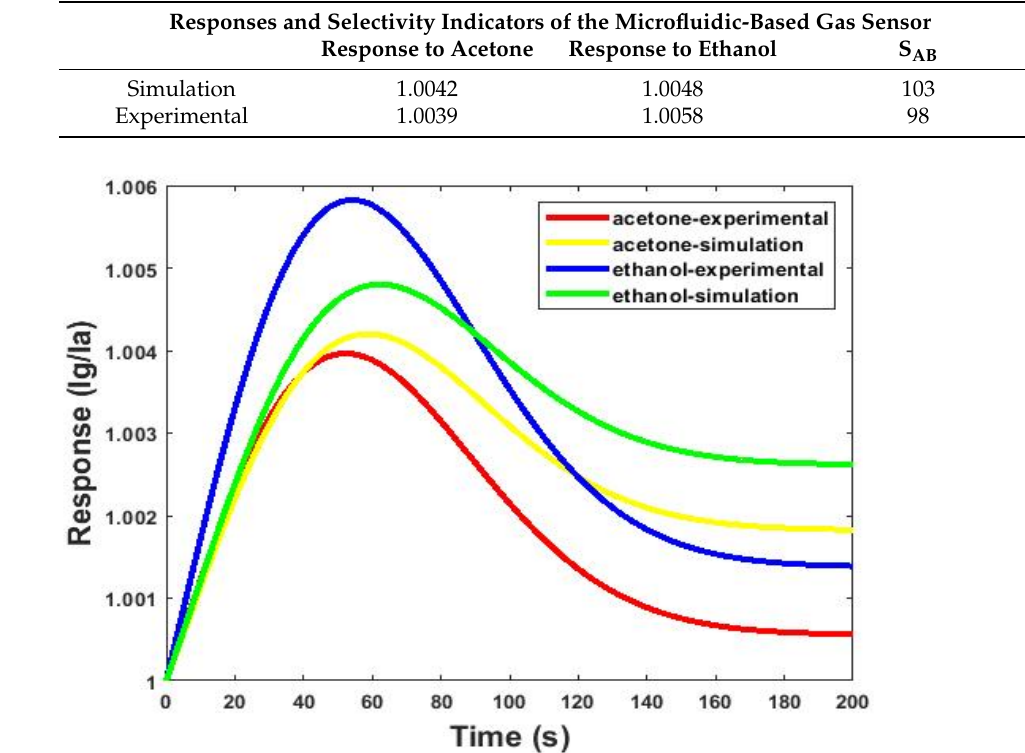
Figure 12. Comparison between the simulation and experimental results of the microfluidic-based gas sensor with optimal dimensions (W = 3 mm, L = 22.5 mm, H = 80 µm) in the presence of 2.6 ppm concentrations at 27 °C.